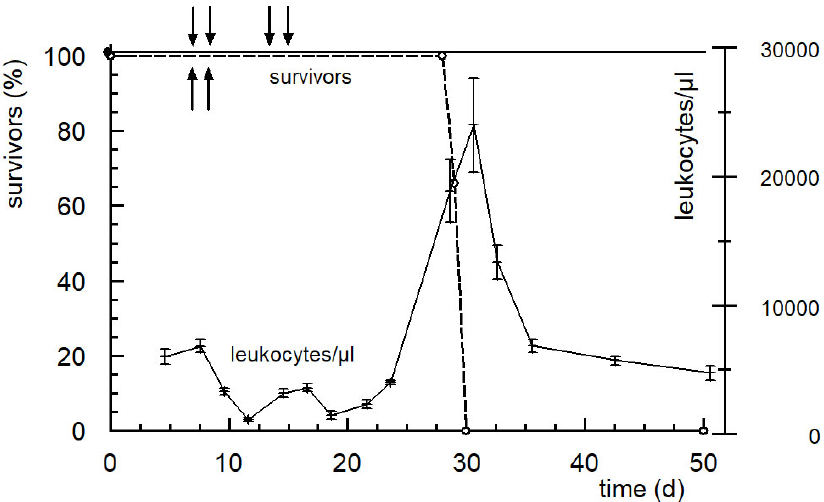
Figure 7. Survival curves of CD2F1 mice bearing subcutaneously transplanted solid growing P388 tumors following therapy with 666 mg / kg SUM-IAP on days 7 and 8 (upward arrows, broken line, 3 animals) and therapy following 666 mg / kg SUM-IAP on days 7 and 8 and on days 14 and 15 (downward arrows, solid line, 5 animals) and the number of leucocytes following therapy on days 7.8 and 14.15 (mean values +/ − SD). The median survival time of untreated tumor-bearing controls was 11–12 days.